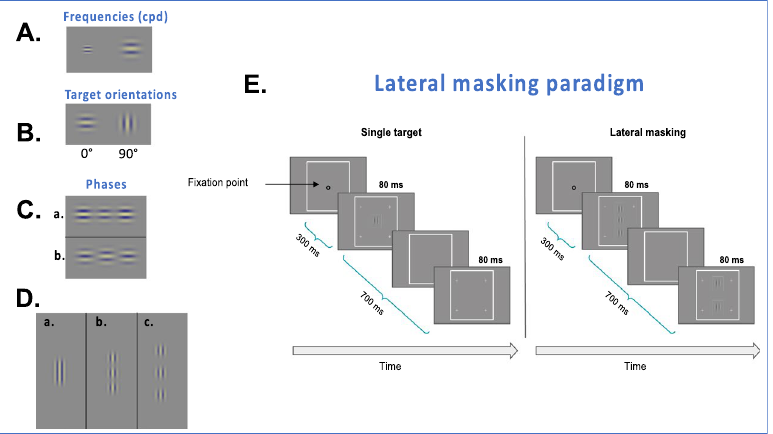
Figure 1. ( A ) Illustration of the two different frequencies used in Experiment 3: on the left, a Gabor Patch (GP) of 8 cpd (cycles per degree), and on the right, a GP of 4 cpd. ( B ) Illustration of the single-target orientations. ( C ) Illustration of a central GP target flanked by a pair of GP masks with (a) an equal phase pattern and (b) an opposite phase pattern. ( D ) Examples of some target-to-flanker separations. (a) 1.5λ (b) 3λ, and (c) 6λ. ( E ). The lateral masking paradigm used for the sets of experiments. Observers had to report in which interval (the first or the second) the central Gabor target appeared. The contrast in all the targets was enhanced for demonstration purposes.